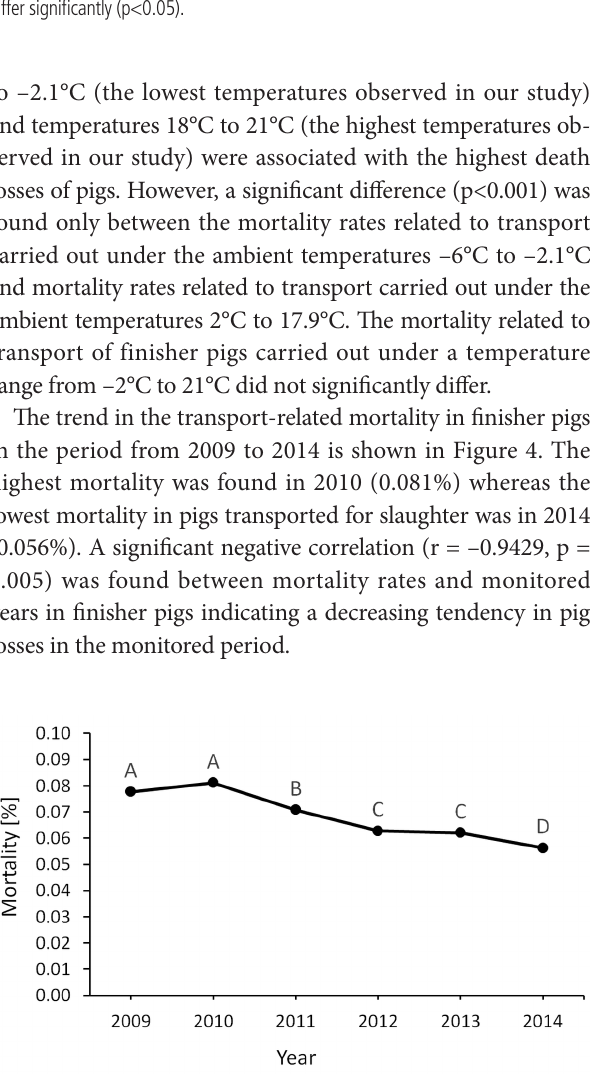
Figure 3. Transport-related mortality of finisher pigs as affected by the ambient temperature (mean±standard error of the mean). a,b Means with different superscripts differ significantly (p<0.05).